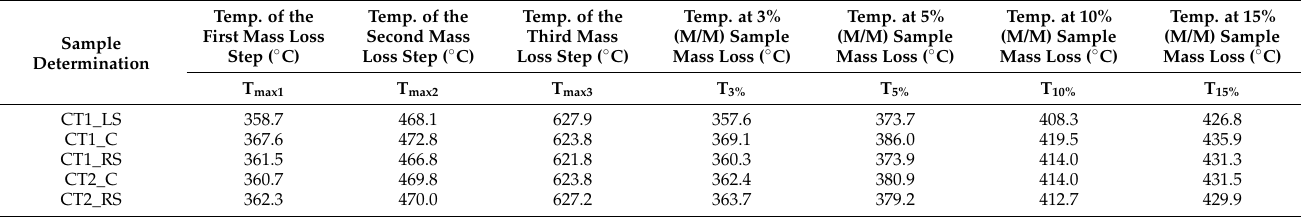
decomposition of the material while heating the samples at a constant rate of 20 ◦ C/min. Table 2 presents the sample mass loss at particular mass loss steps and the sample mass residue at the final temperature of the TGA analysis. Table 1. Sample mass loss step temperatures read from the DTG curves from thermogravimetric analysis and temperatures of specified sample mass